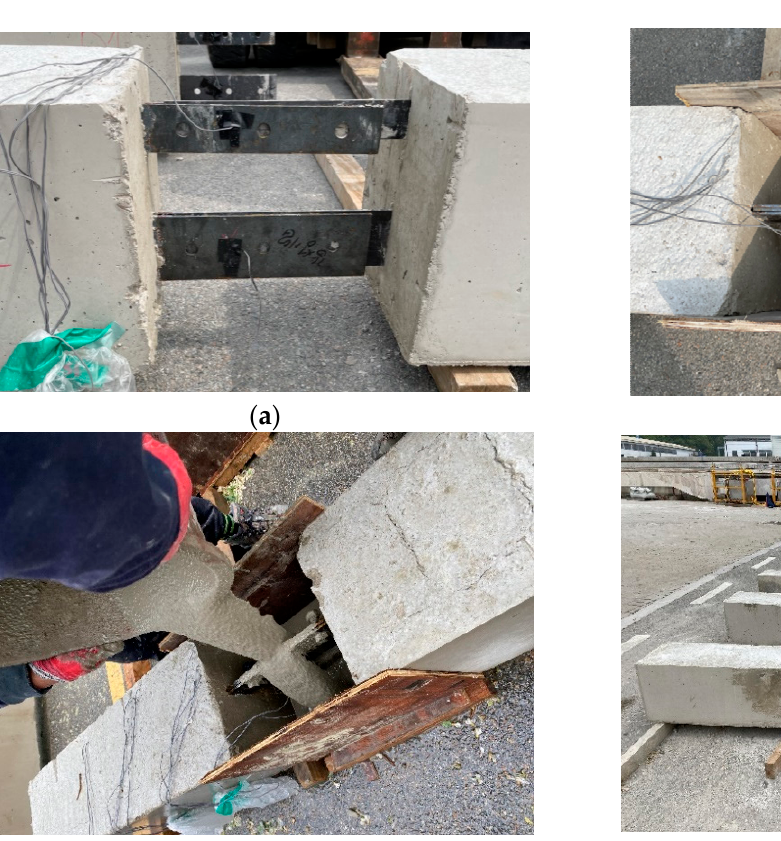
Figure 5. Drawings of the specimens for flexural and shear tests (mm): ( a ) monolithic specimens; ( b ) PC modular speci- mens; ( c ) sideview of monolithic beam specimens; ( d ) sideview of precast concrete modular specimens; ( e ) A-A section; ( f ) B-B section.